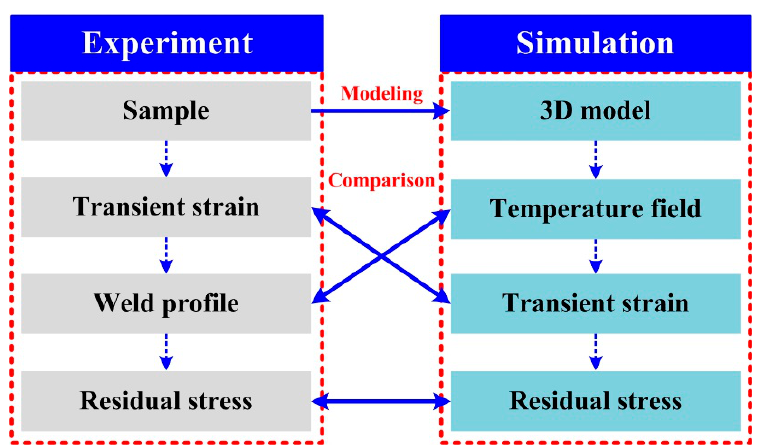
Figure 1. Investigation framework of this work.